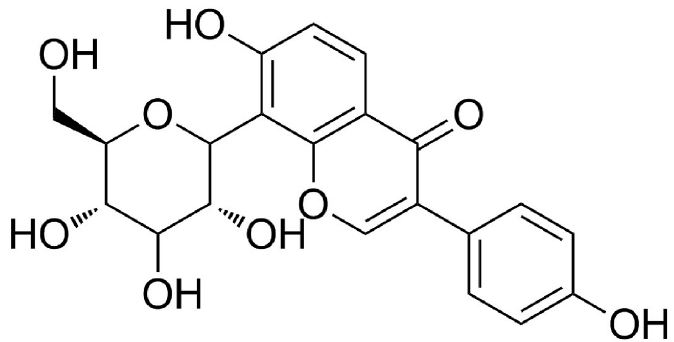
Figure 1. Chemical structure of puerarin.